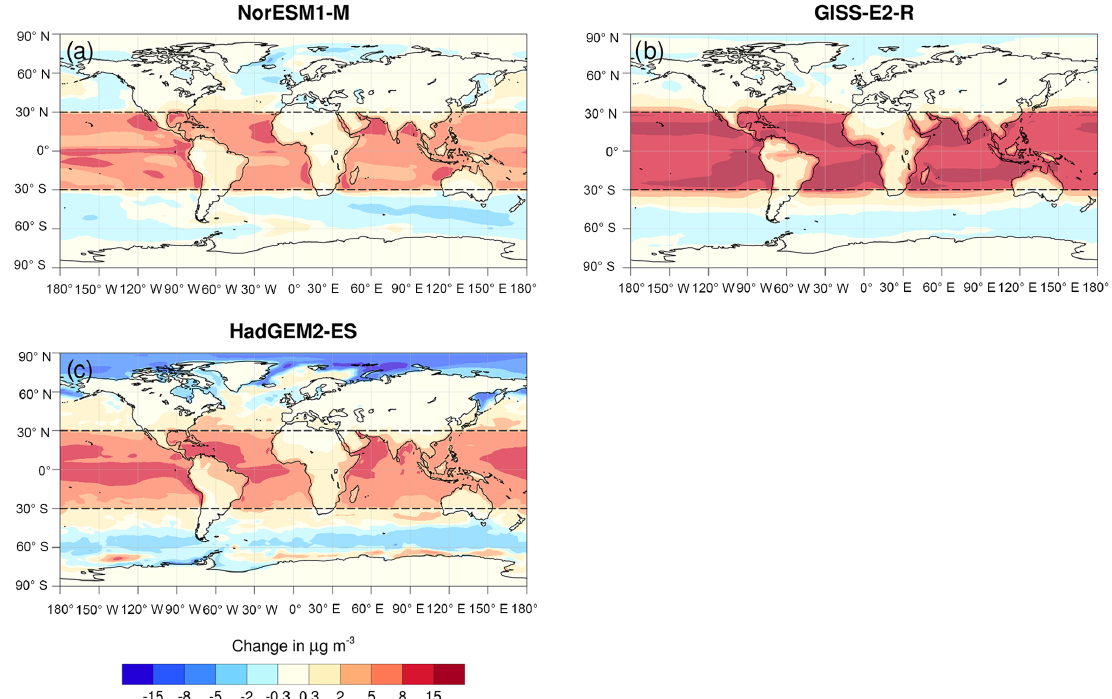
Figure 6. Mean difference in sea salt mass concentration in the lowest model layer between G4sea-salt and RCP4.5 averaged over 2035 and 2065, for (a) NorESM1-M, (b) GISS-E2-R, and (c)